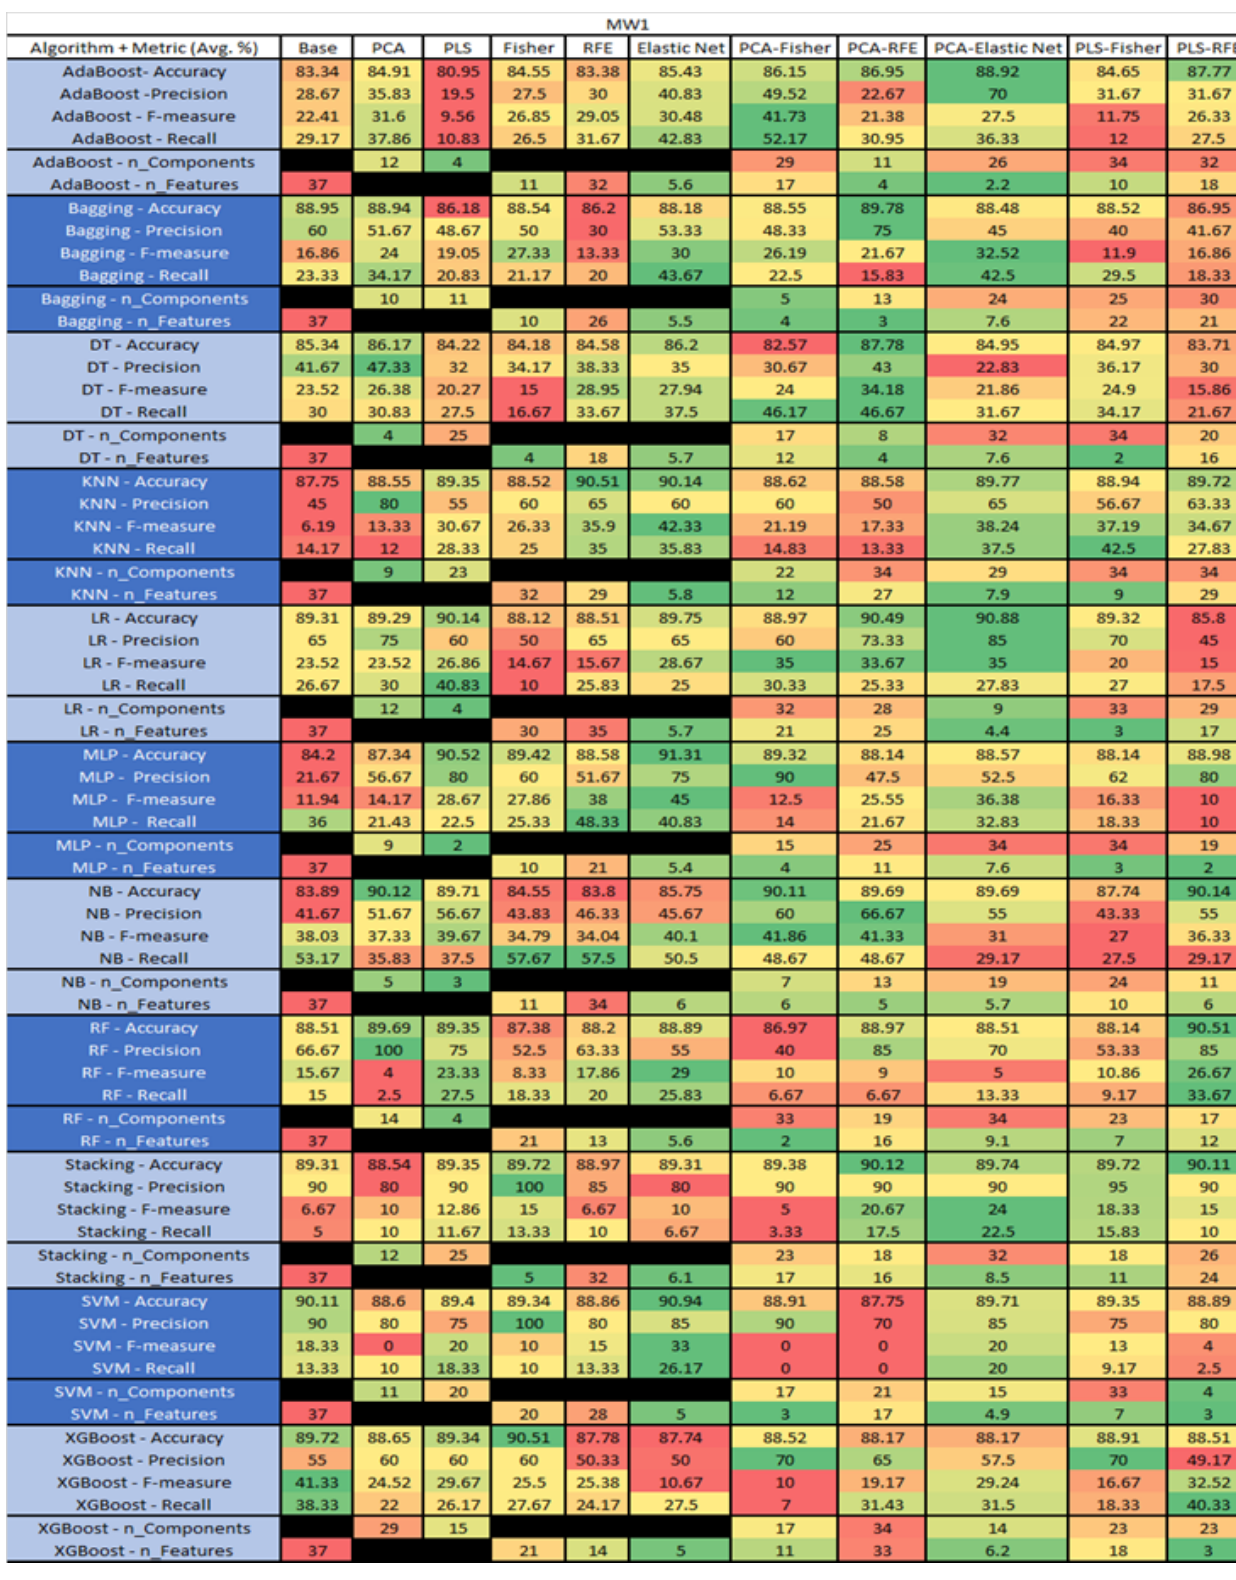
Figure 38. MW1 NASA MDP Results Data